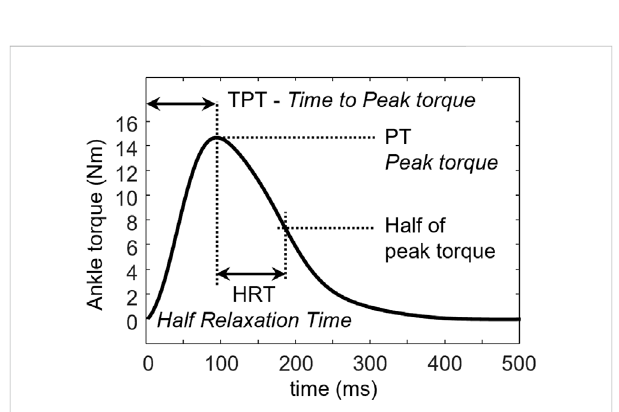
Half relaxation time (HRT) is de fi ned as the time needed by the muscle to relax from the peak torque (PT) to 50% of its peak value. Time to peak torque (TPT) is de fi ned as the time from the onset of the torque to